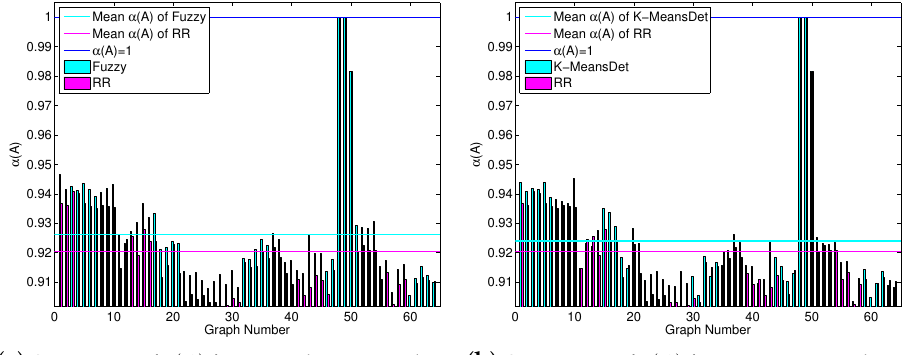
( a ) Comparison of α ( A ) for Fuzzy clustering and RR. ( b ) Comparison of α ( A ) for K-MeansDet and RR.